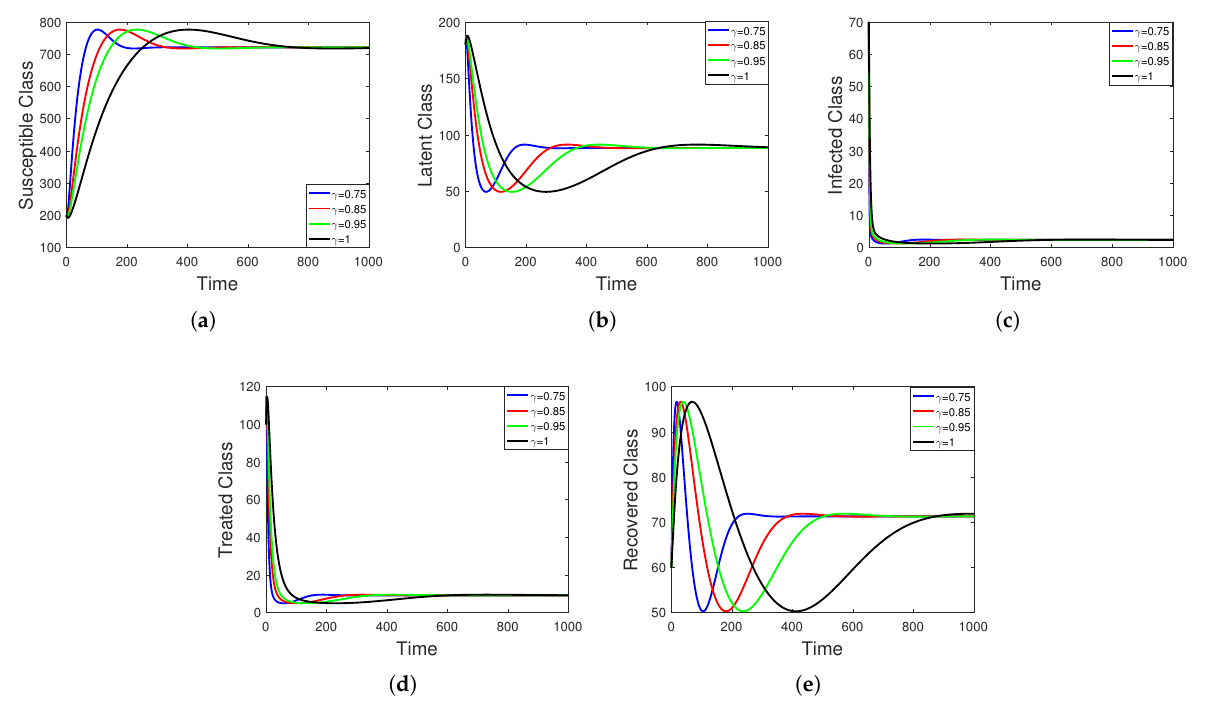
Figure 5. A graphical representation of human compartments ( a – e ) on different arbitrary orders γ = 0.75, 0.85, 0.95, 1 for initial data and time duration for the TB model by taking the value of p = q = 0.6.